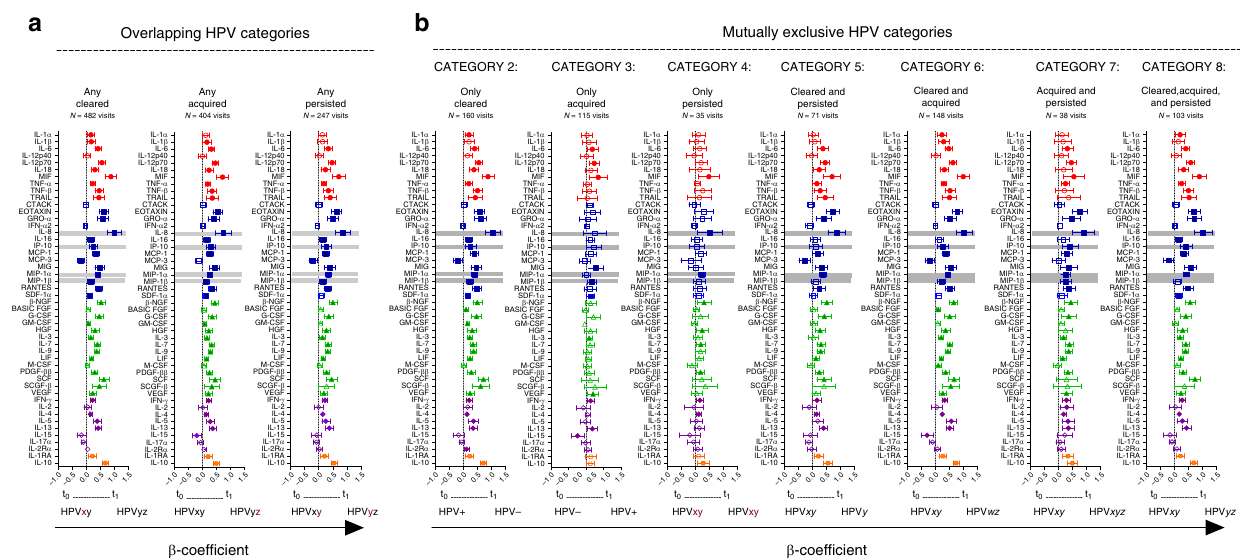
Fig. 5 Association between HPV infection and genital cytokines over time. Figure 5a: Plots depict the mean differences in genital cytokine concentrations at visits where the overlapping de fi nitions of HPV clearance ( N = 482 visits), acquisition ( N = 404 visits) and persistence ( N = 247 visits) were observed, respectively, relative to category 1, where participants remained HPV negative ( N = 173 visits). Figure 5b : Mean differences in genital cytokine concentrations between category 1 ( N = 173) and visits where the HPV categories 2 – 8 were observed. The number of visits compared to category 1 in multivariable models are listed beneath each category. Individual associations are shown between HPV status and pro-in fl ammatory cytokines (red), chemokines (blue), growth/hematopoietic factors (green), adaptive response cytokines (purple), and regulatory cytokines (orange), with error bars depicting 95% con fi dence intervals. The models test the hypothesis that the mean cytokine levels in comparator groups are equal i.e. β = 0. The dotted line at β = 0 distinguishes higher (to the right of the line) from lower (to the left of the line) mean cytokine differences in the respective categories relative to the remained HPV negative group. Gray shadings represent genital cytokines previously associated with HIV risk in this cohort: IP-10, IL-8, MIP-1 α , and MIP-1 β . Filled shapes represent signi fi cant associations after false discovery rate (FDR) adjustment using a threshold of 0.05 in multivariable models controlling for baseline treatment group, age, age of sexual debut, number of sexual partners, number of sex acts (past 30 days), presence of STI symptoms, HSV-2 status, condom use, marital status, and whether women were living with regular partners. The fi gures are annotated to describe the temporal dynamics of the HPV infection, with t 0 referring to the HPV status at the last visit prior to that at t 1 , at which cytokine concentrations were measured for both that category and for the category 1 control. Hypothetical HPV type infections are listed beneath to clarify the de fi nition. For example: for “ ANY HPV CLEARANCE ” between t0 and t1, the clearance of HPV (HPV type-x) can be observed in the presence of acquisition (HPV type-z) or persistence (HPV